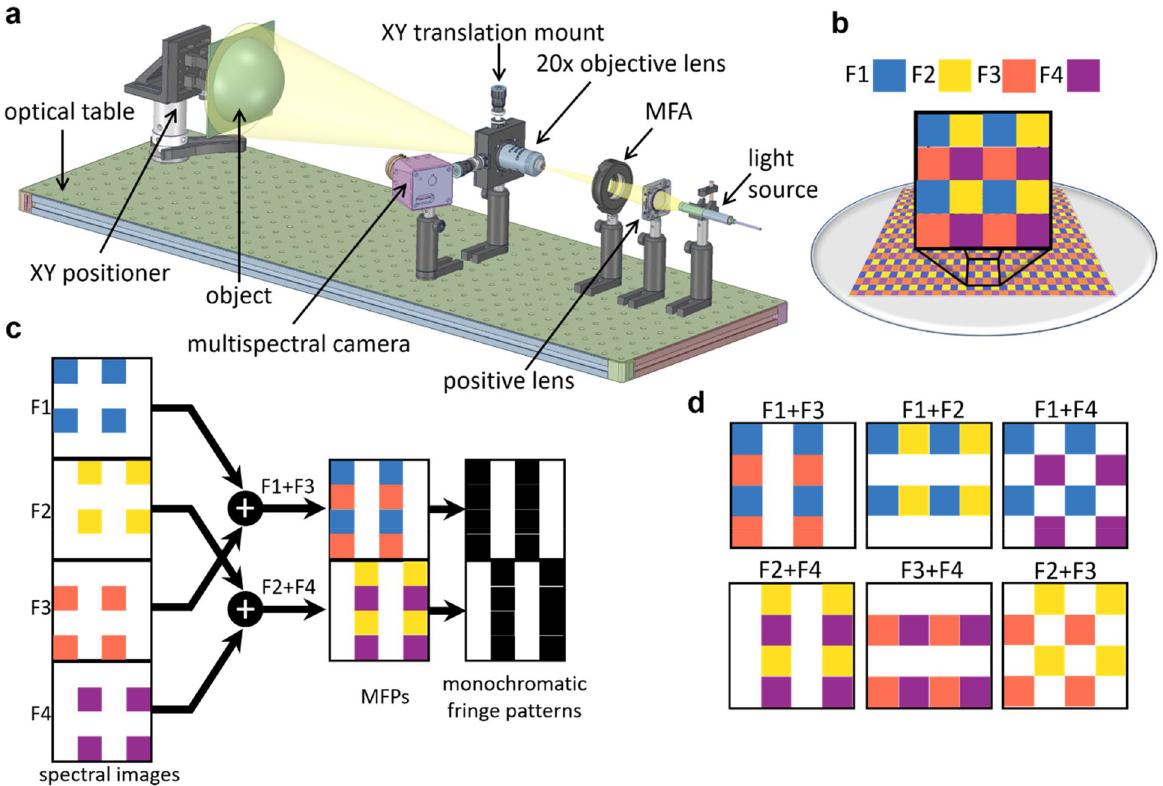
Figure 1. ( a ) Schematic illustration of the setup consisting of a halogen light source, multispectral filter array (MFA), focussing lens, object, and snapshot multispectral camera. ( b ) The MFA consisted of a 2D array of four distinct filters at different wavelengths: 580 nm, 660 nm, 735 nm, and 820 nm indicated by blue (F1), yellow (F2), orange (F3), and purple (F4), respectively. ( c ) Schematic of 2 vertical MFPs generated by combining pairs of spectral images of the object to form 2 unique monochromatic fringe patterns. For clarity, a single 4 × 4 pixel area is shown for each filter type, but the concept extends across all pixel data in each spectral image. ( d ) Schematic of all 6 MFPs, distinguishable as 8 unique monochromatic fringe